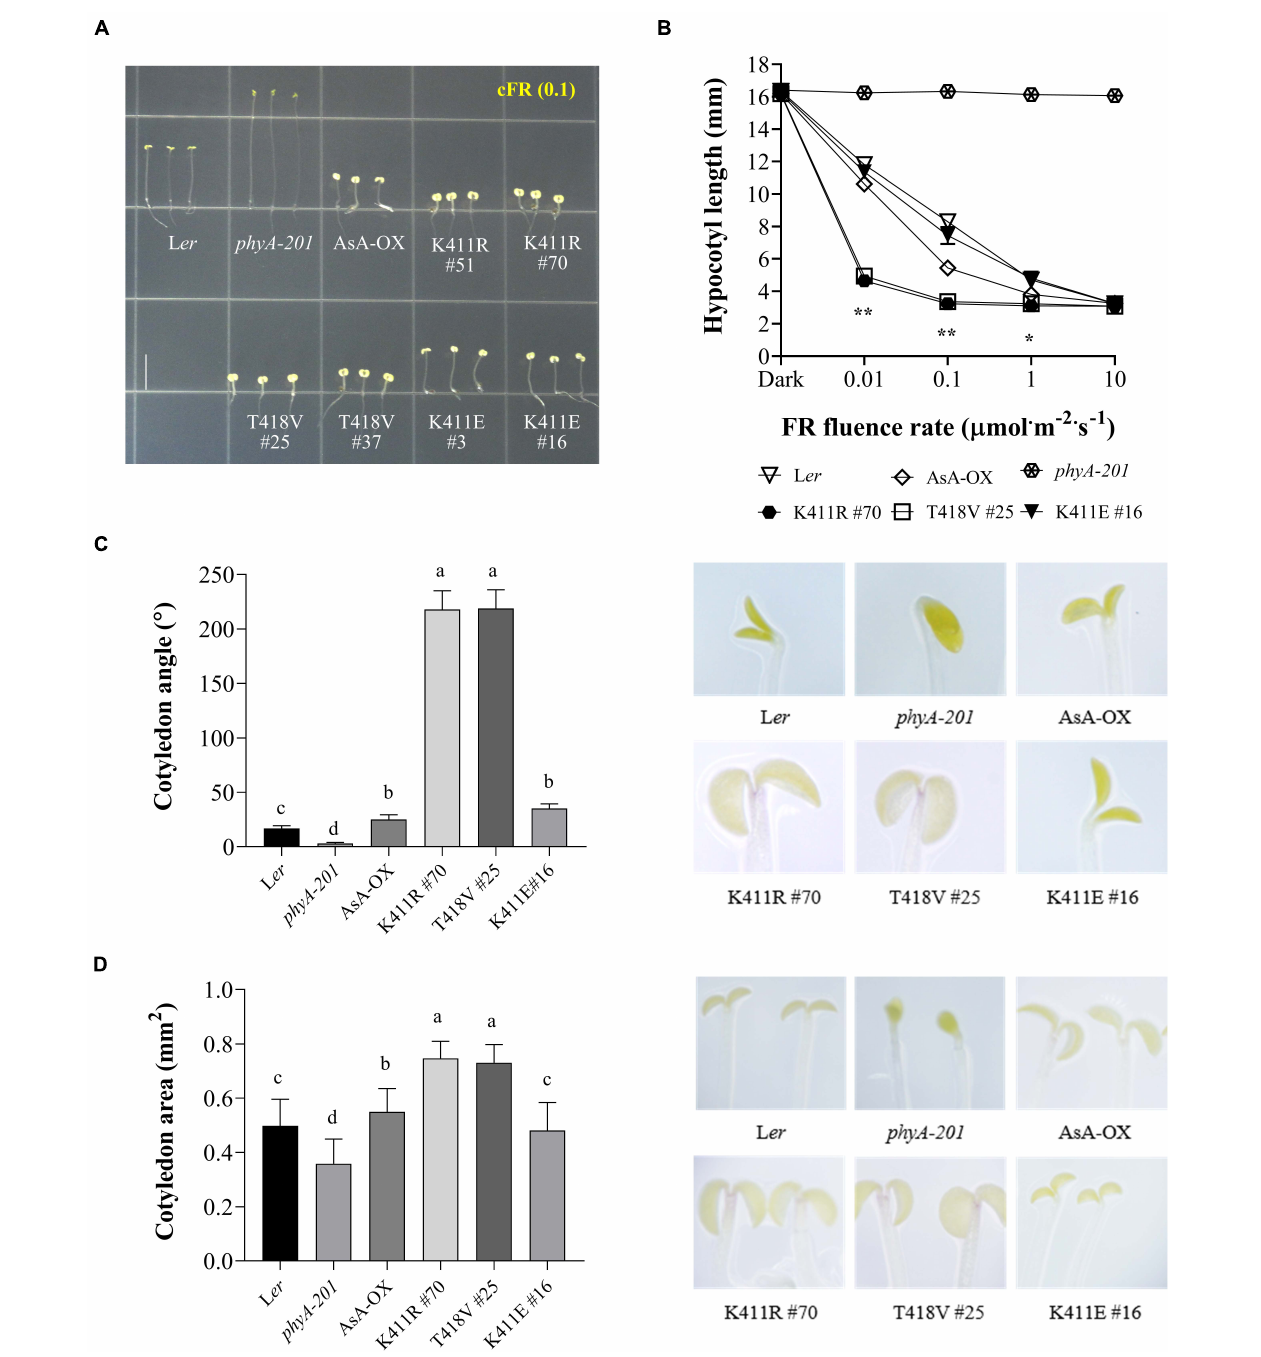
FIGURE 2 | Far-red photoresponse analyses of transgenic phyA-201 plants with AsphyA kinase mutants. (A) Hypocotyl de-etiolation of representative 4.5-days-old seedlings grown under continuous far-red (cFR, 0.1 µ mol · m − 2 · s − 1 ) light. L er , wild-type Arabidopsis; phyA-201 , phyA-deficient Arabidopsis (L er ecotype); AsA-OX, transgenic phyA-201 with wild-type AsphyA; K411R, T418V, and K411E, transgenic phyA-201 lines with the corresponding AsphyA mutants. Scale bar = 5.0 mm. (B) FR fluence rate-response curves for the inhibition of hypocotyl growth. Data represent means ± SD ( n ≥ 30). Significant changes in comparison to AsA-OX are indicated (* P < 0.05 and ** P < 0.01, Tukey’s test). (C,D) Cotyledon angles and areas of 4.5-days-old seedlings under 0.01 or 0.1 µ mol · m − 2 · s − 1 of cFR light, respectively. Cotyledon angles (C) and areas (D) were measured from the seedling images using ImageJ. Data are means ± SD ( n ≥ 30). Means with different letters are significantly different at P < 0.01, using Duncan’s multiple range